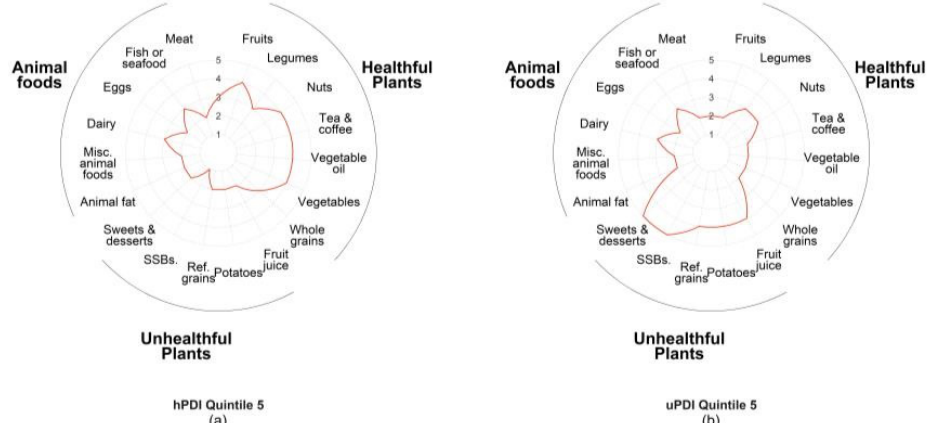
Figure 1. Food groups contributing to plant-based diet indices among breast cancer survivors in the Pathways Study: ( a ) radar plot showing the food consumption patterns of the highest quintile and greatest concordance with hPDI (healthful plant-based diet index). The line represents the median score for each food group within the quintile. A higher score indicates greater consumption of the food group; ( b ) radar plot showing the food consumption patterns of the highest quintile of uPDI (unhealthful plant-based diet index). The line represents the median score for each food group within the quintile. A higher score indicates greater consumption of the food group.